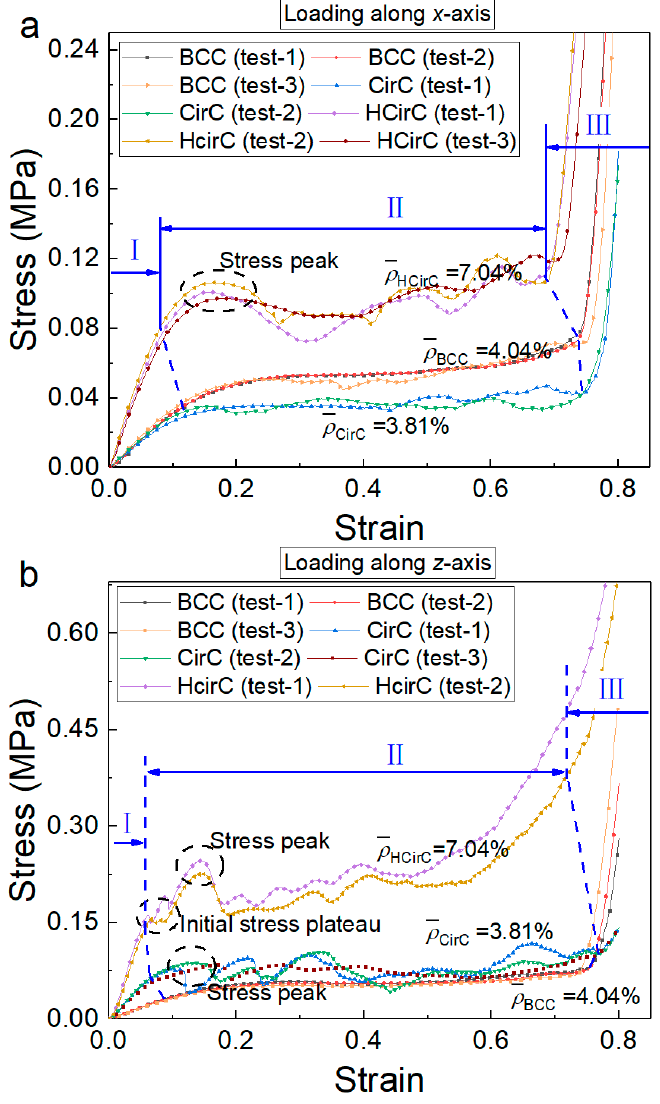
Figure 8. The compression curves of lattice structures BCC, CirC, and HCirC: in ( a ) for compression along the x -axis; and in ( b ) for compression along the z -axis.